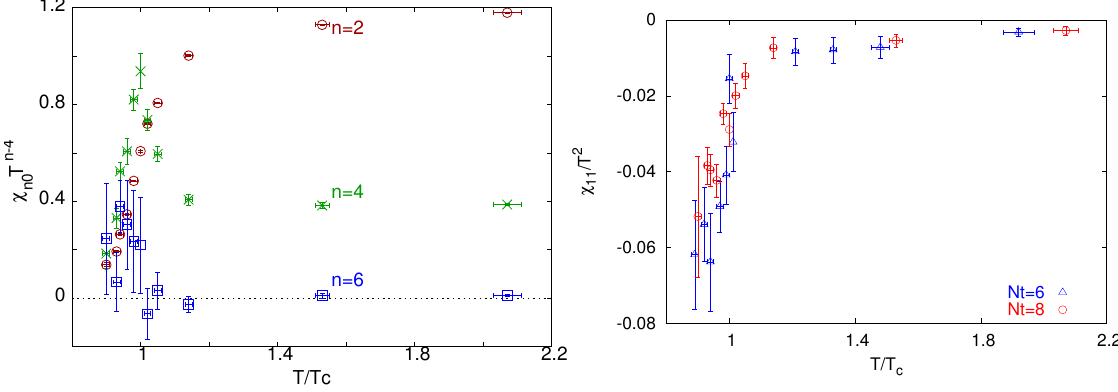
Figure 1. ( left ) The diagonal susceptibilities of order two, four and six, χ 20 / T 2 , χ 40 and T 2 χ 60 , in the temperature range 0.9–2 T c . ( right ) χ 11 in units of T 2 , on lattices with a = 1/8 T . Also shown for comparison are results for lattices with a = 1/6 T